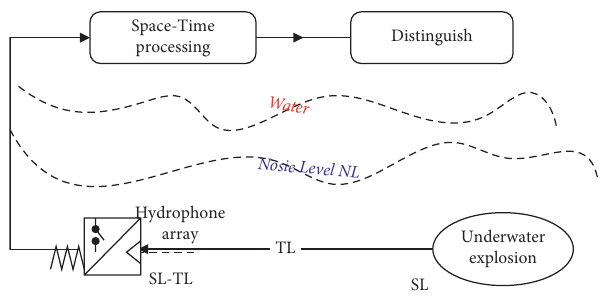
Figure 2: Function of the passive sonar.